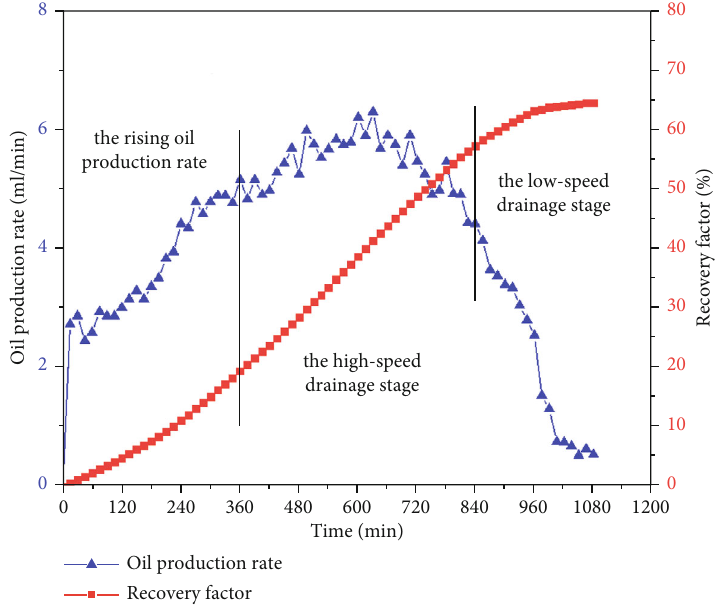
Figure 7: Change in the oil production rate and recovery factor with time in Experiment